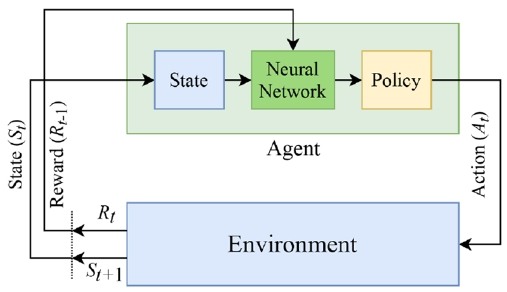
Figure 4. The block diagram of the DQL system. The key difference with QL is the use of a neural network in the learning process of the